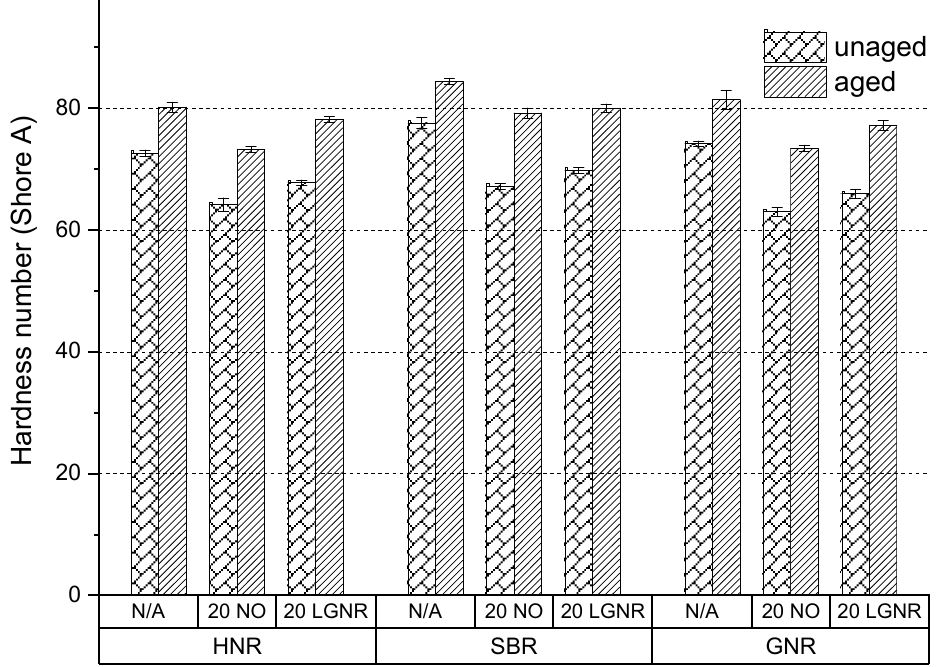
Figure 18. Aging effects on the hardness number of HNR, SBR and GNR composites made with or without processing aids. N/A: rubber compounds without processing aids; 20 NO: rubber compounds with 20 phr naphthenic oil; 20 LGNR: rubber compounds with 20 phr liquid guayule natural